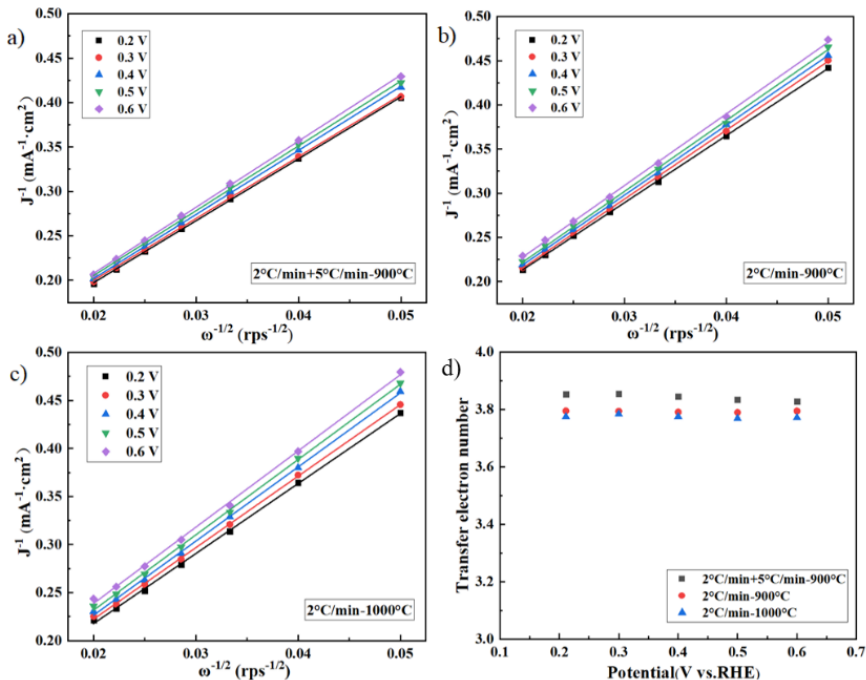
Figure 10. ( a ) K–L plots of Co–ZIF–8 pyrolyzed at 2 °C/min + 5 °C/min–900 °C; ( b ) K–L plots of Co– ZIF–8 pyrolyzed at 2 °C/min–900 °C; ( c ) K–L plots of Co–ZIF–8 pyrolyzed at 2 °C/min–1000 °C, ( d